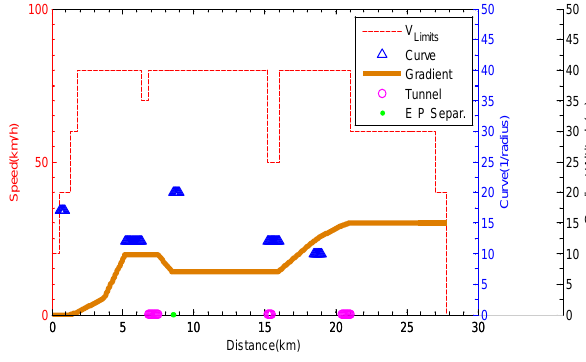
Figure C1. Graphical display of the railway line matrix.